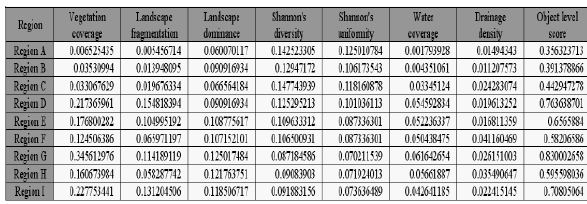
Table 3. Iterative computation Ⅱ